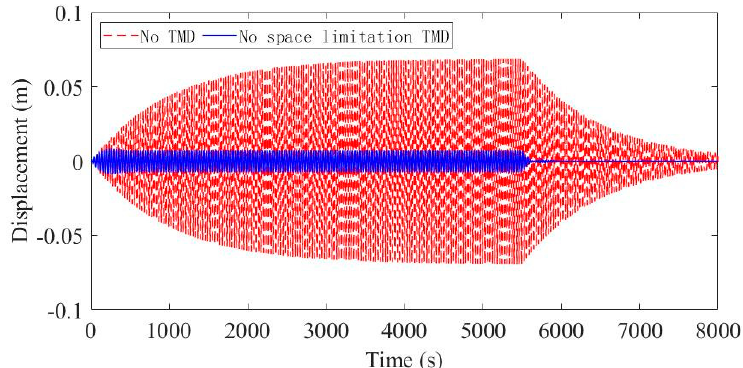
Figure 18. Comparison of free decay of floating wind turbine with stroke-unlimited TMD and with- out TMD.